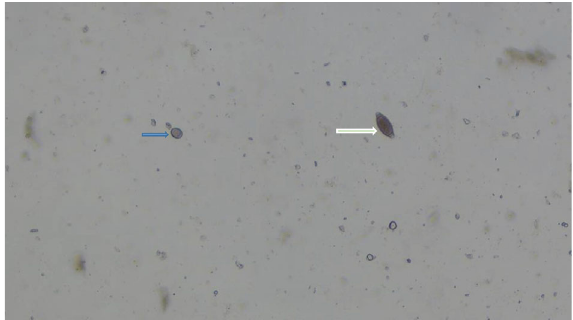
Figure 4: Coccidian cyst (blue arrow) and Trichuris suum (white arrow).